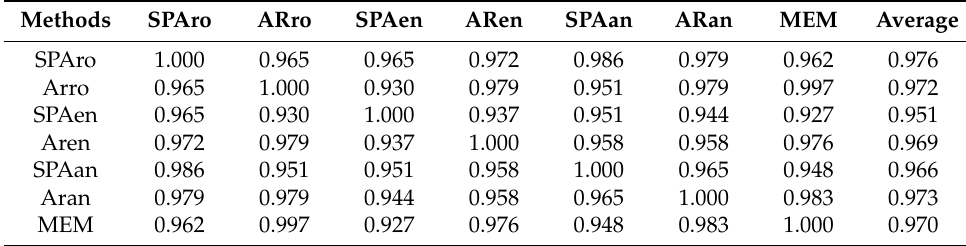
Table 11. Spearman rank correlation